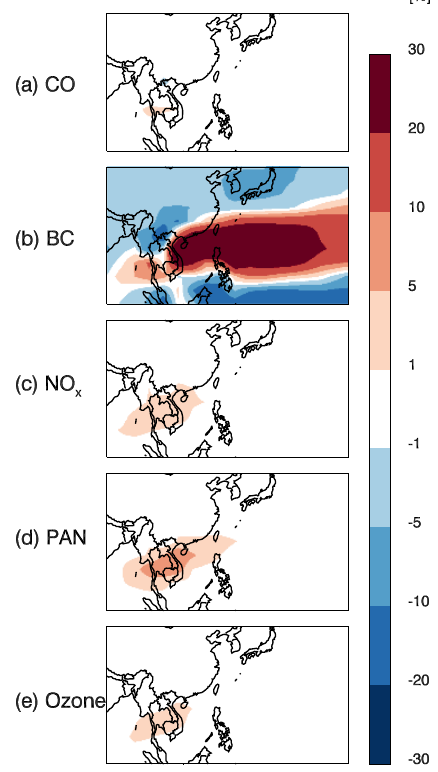
Fig. 5. Percent differences of tropospheric column (a) CO, (b) BC, (c) NO x , (d) peroxyacetyl nitrate (PAN), and (e) ozone concentra- tions in the MISR-constrained simulation relative to control simu- lation during March 2001.